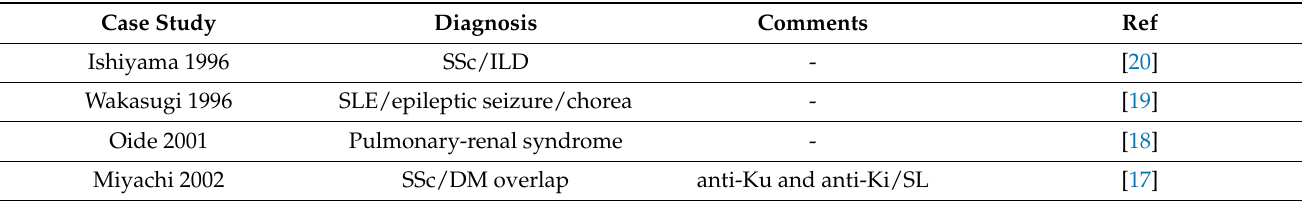
Table 1. Overview of case studies including the measurement of anti-Ki/SL antibodies.